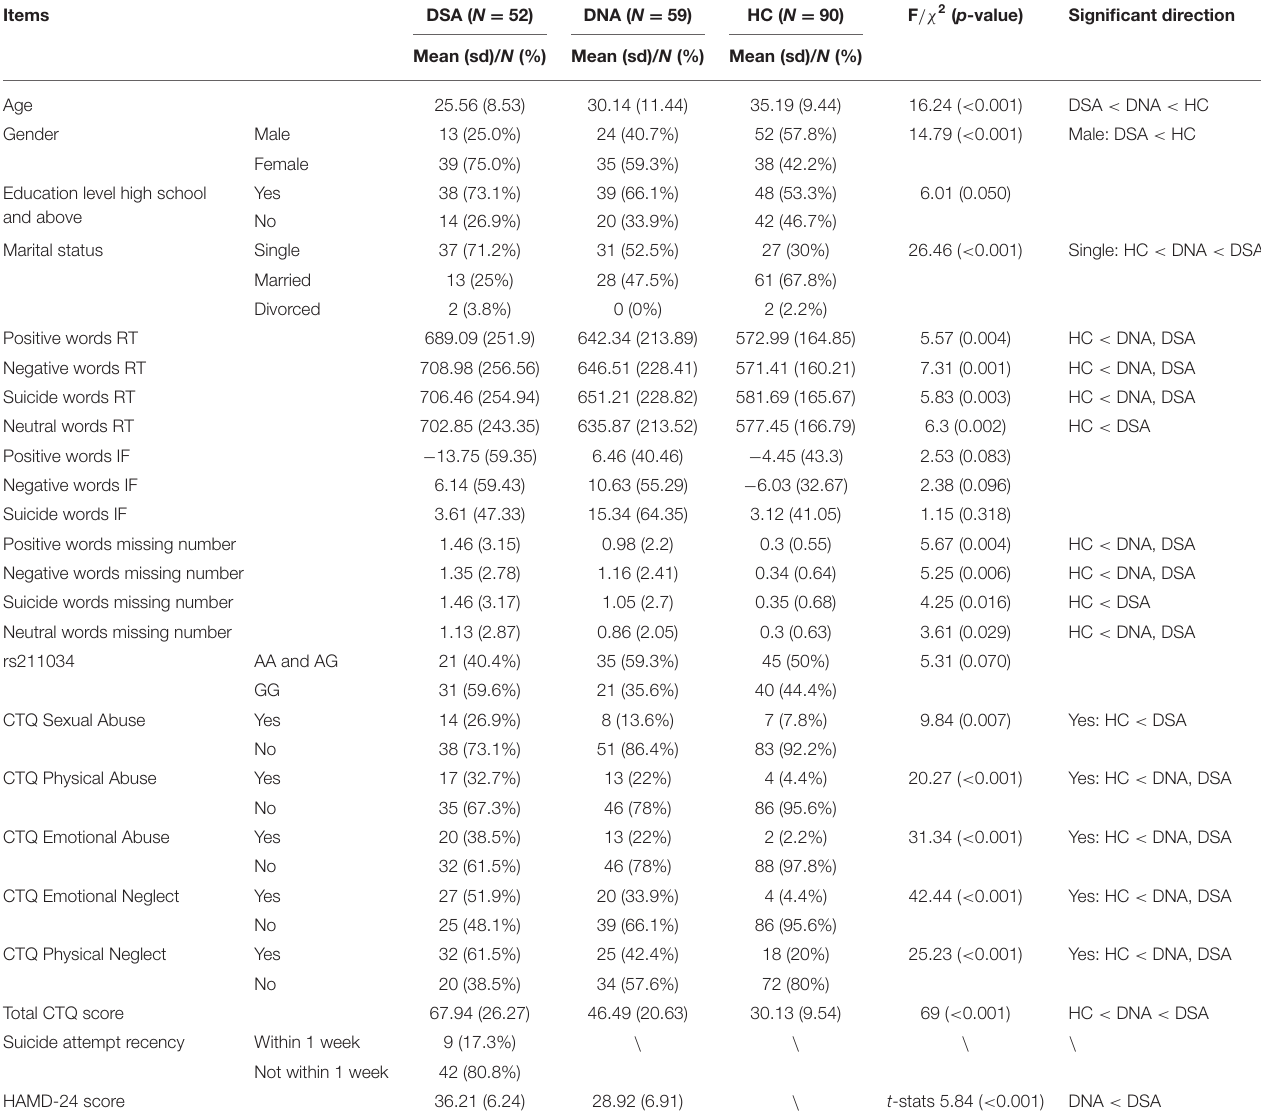
TABLE 1 | Demographic and clinical features, as well as comparison results without adjusting covariates.